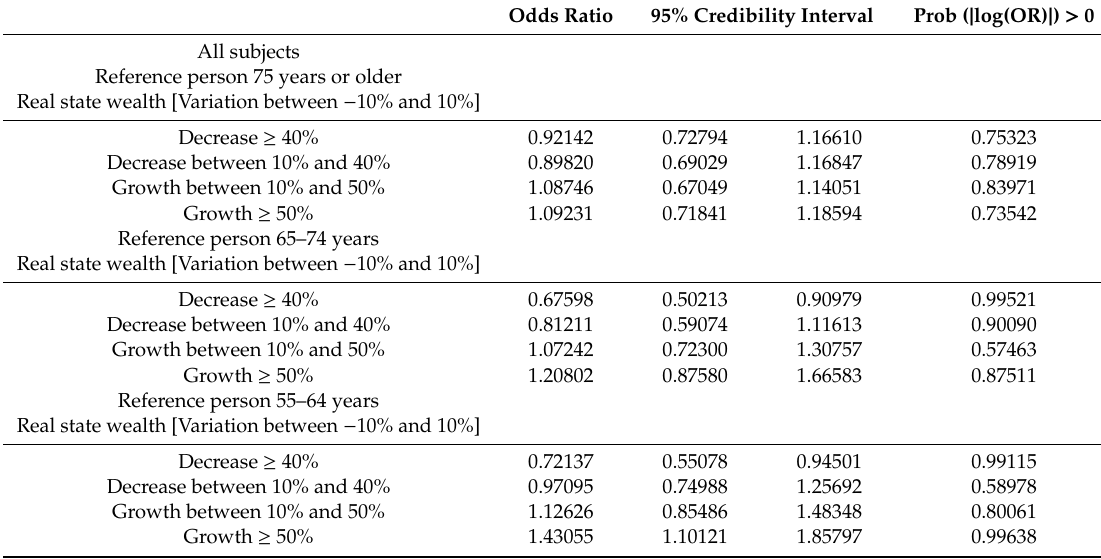
Association between the variation in real estate wealth and good and very good self-perceived health.